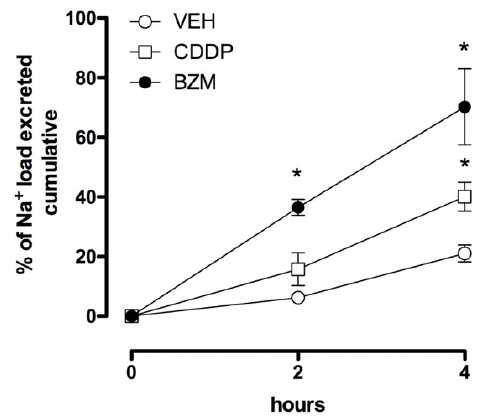
Figure 1. Cisplatin (CDDP) is natriuretic. Summary graph showing cumulative Na + excretion in mice that received an Na + load and treatment with cisplatin (CDDP, the black circles, where n = 5 independent trials with three mice per trial), benzamil (BZM, the white squares, where n = 5 independent trials with three mice per trial) or the vehicle (VEH, the white circles, where n = 5 independent trials with three mice per trial) over a 4 h period. Treatment with BZM significantly increased Na + excretion at both the 2 h and 4 h time points. Treatment with CDDP significantly increased excretion at the 4 h time point, where BZM and CDDP were not different. * p < 0.05 vs. VEH group.